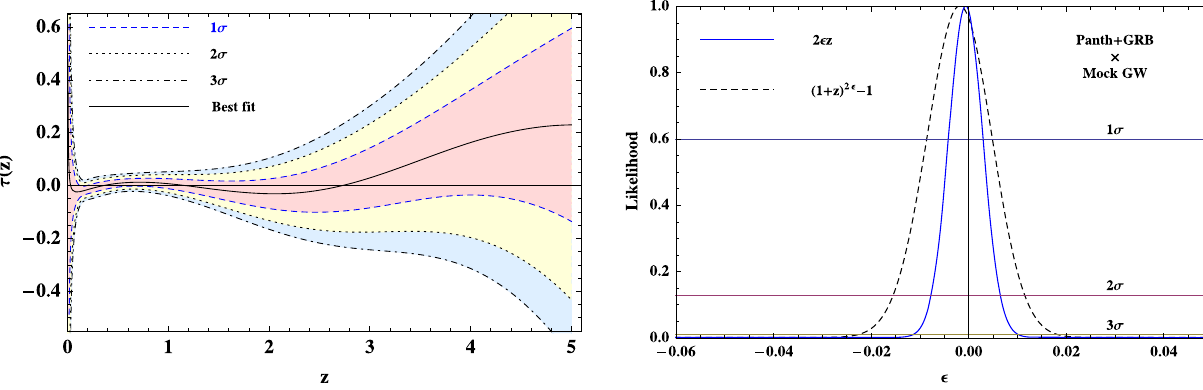
Fig. 2 The cosmic optical depth function τ( z ) (left panel) and the likelihood distribution functions (right panel) obtained from the combination of ‘Pantheon-like’ and ‘GRB-like’ data with (cid:2) CDM constrained between − 0 . 09 and 0 . 05 at 1 σ CL in the redshift region 0 . 1 < z < 2 . 0, and it is constrained between − 0 .